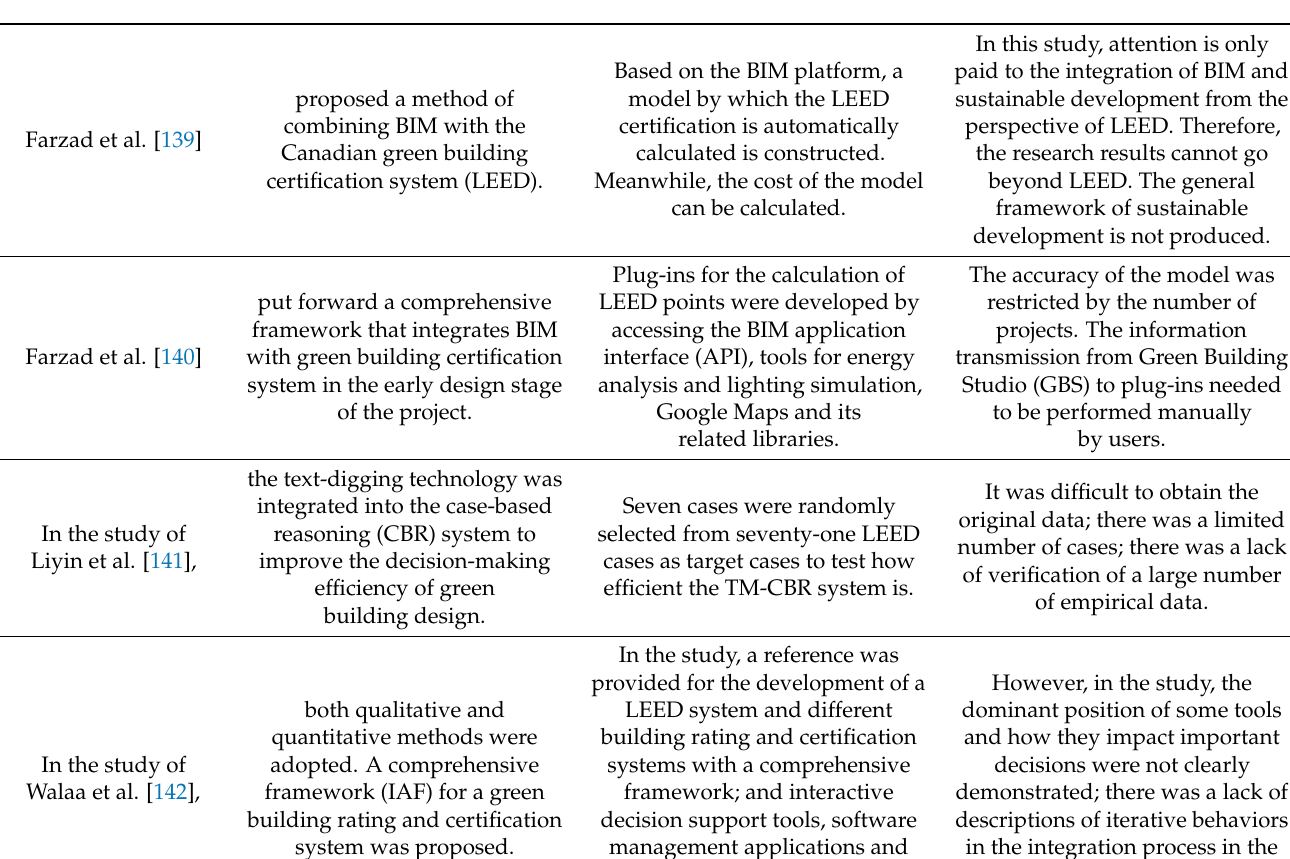
Table 7. Relevant literature where the list method is